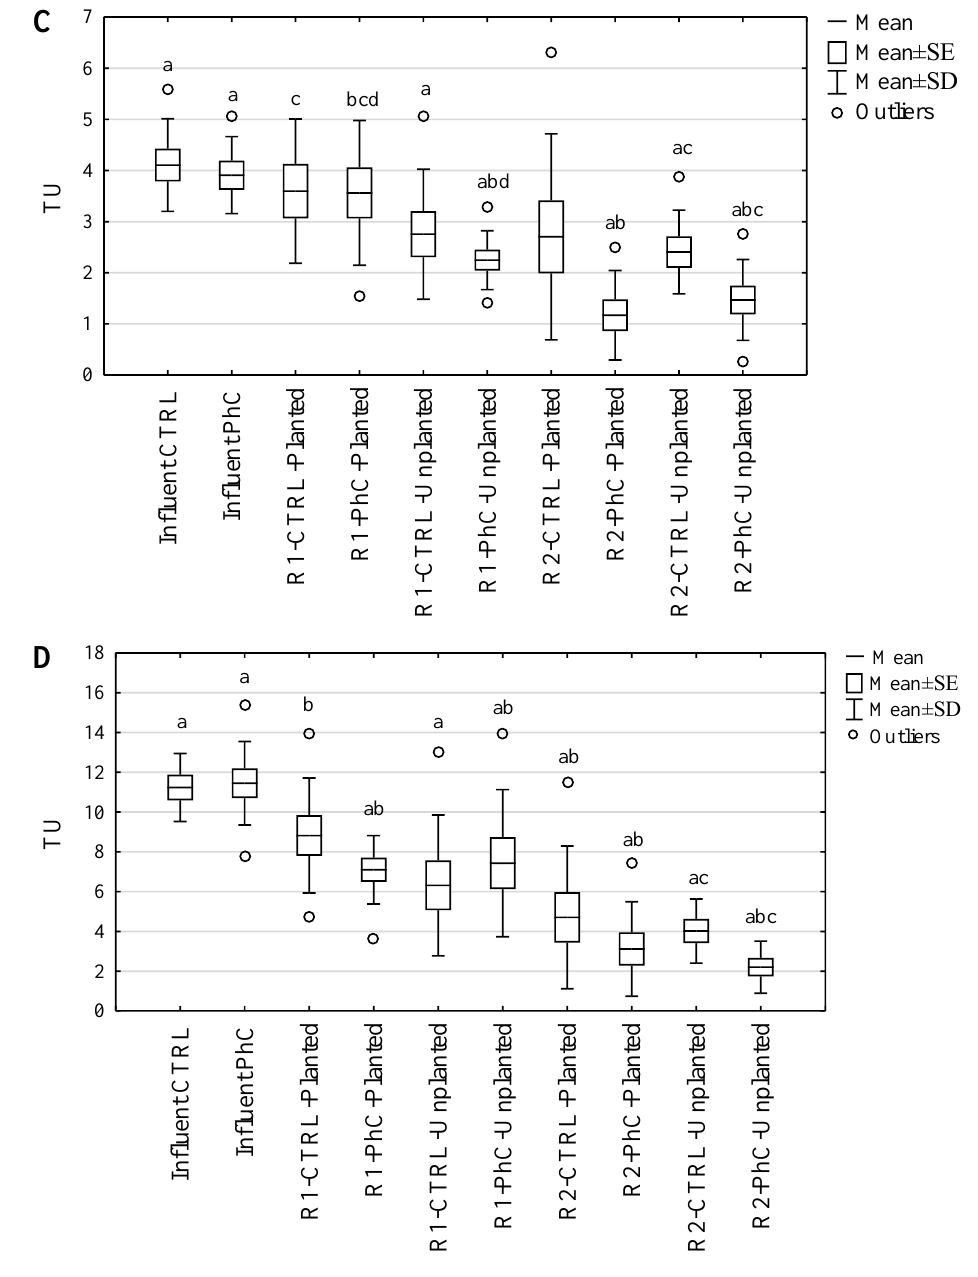
Figure 4. Toxicity of wastewater to aquatic organisms: ( A ) A. fischeri ; ( B ) D. magna , 24 h; ( C ) D. magna , 48 h; ( D ) L. minor . (a) Statistically significant differences between the wastewater influent and effluent (Student ’ s t -test, α = 0 .05); (b) statistically significant differences between counterpart types of columns (CTRL or PhC) with different frequency of wastewater dosing (Student ’ s t -test, α = 0.05); (c) statistically significant differences between control wastewater and wastewater containing pharmaceuticals (Student ’ s t -test, α = 0 .05); (d) statistically significant differences between wastewater from planted columns and from columns without plants (Student ’ s t -test, α = 0 .05). Based on these data, the average wastewater toxicity reduction (WTR, %) was calcu- lated according to Equation (5) and is presented in Appendix A — Table A6.